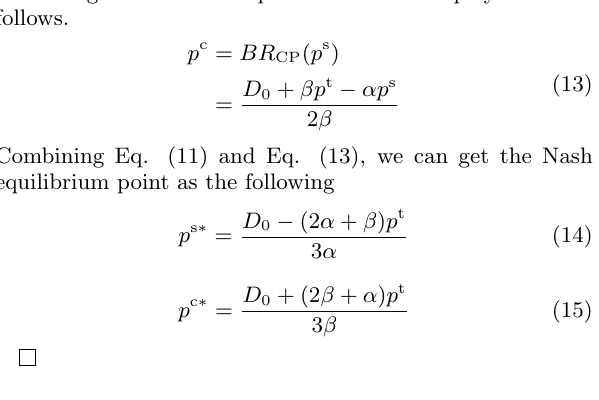
Figure 2: Stackelberg-Bertrand game